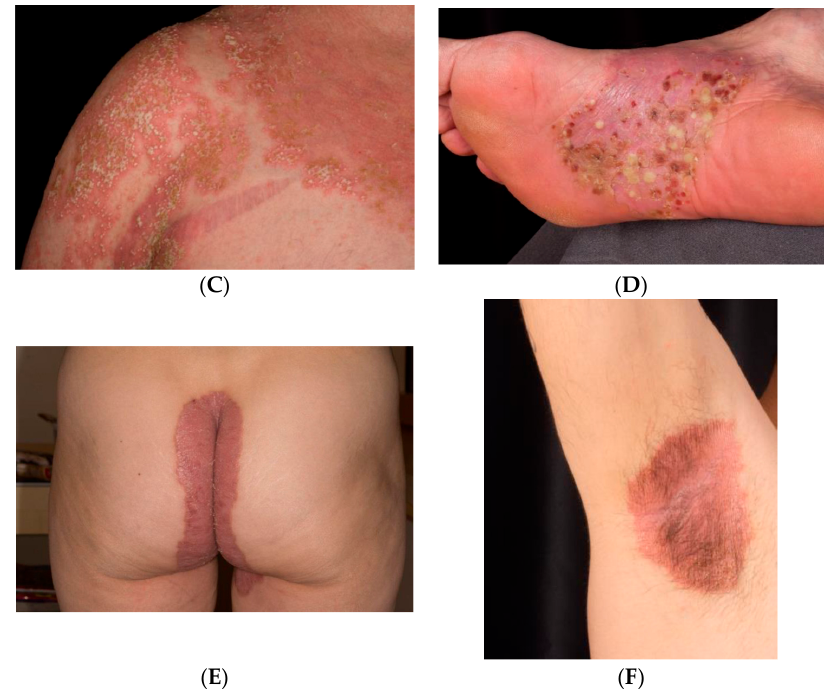
Figure 1. Clinical manifestations of psoriasis. ( A , B ) Psoriasis vulgaris presents with erythematous scaly plaques on the trunk and extensor surfaces of the limbs. ( C ) Generalized pustular psoriasis. ( D ) Pustular psoriasis localized to the soles of the feet. This variant typically affects the palms of the hands as well; hence, psoriasis pustulosa palmoplantaris. ( E , F ) Inverse psoriasis affects the folds of the skin (i.e., axillary, intergluteal, inframammary, and genital involvement).